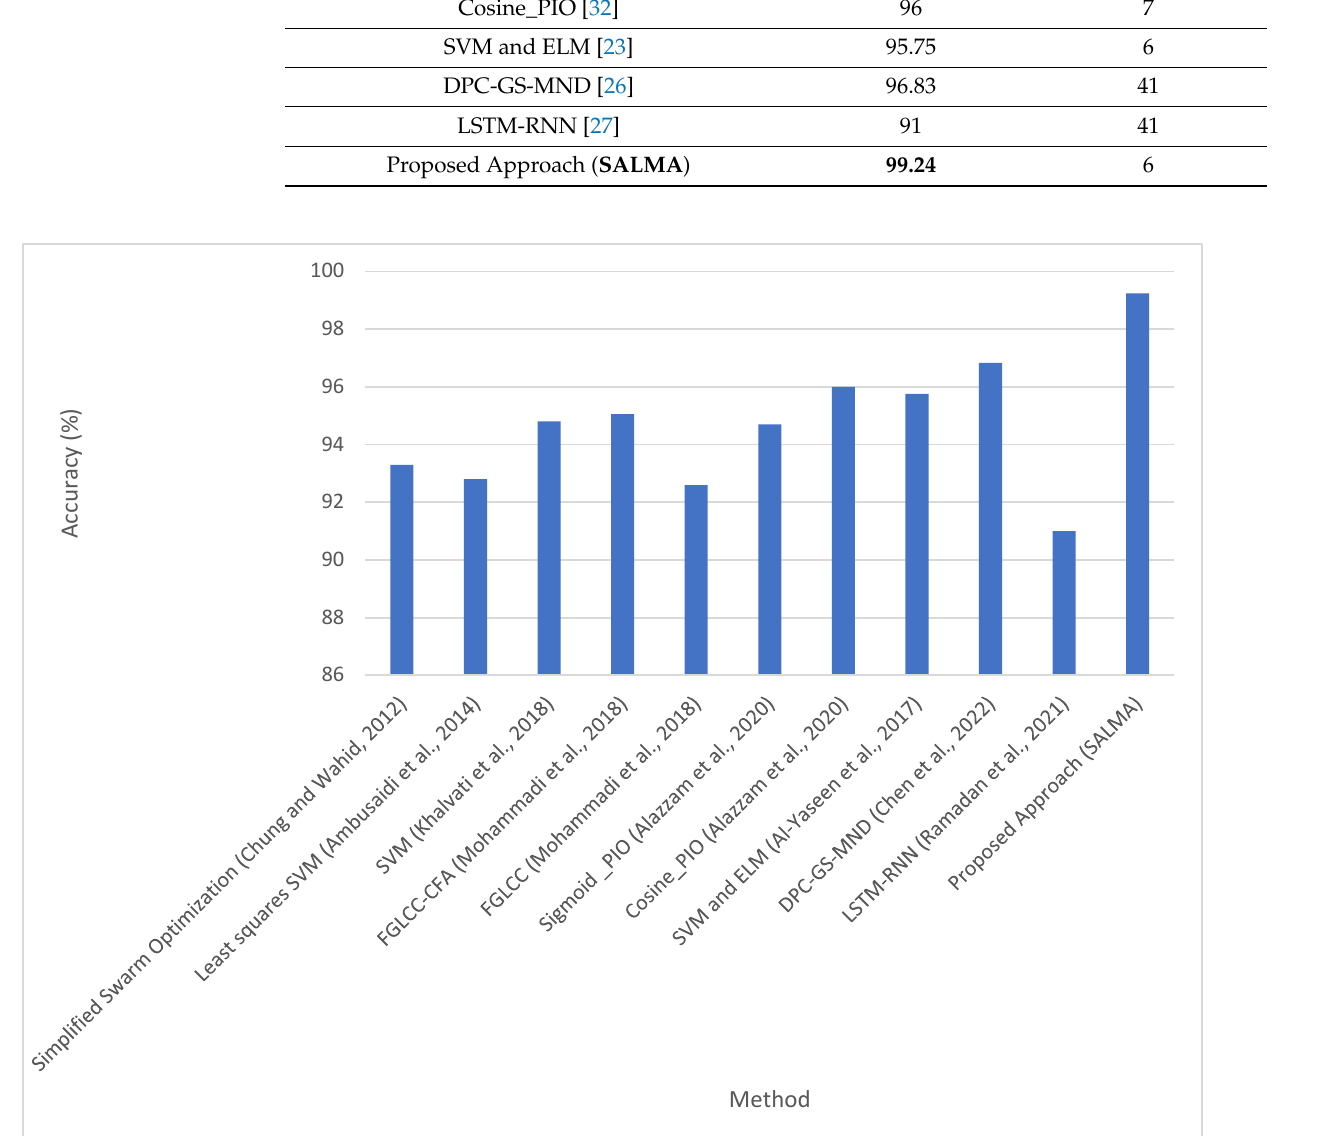
Figure 12. Accuracy comparison between the SALMA and previous approaches on the KDDCUP99 dataset [21,24 – 30].